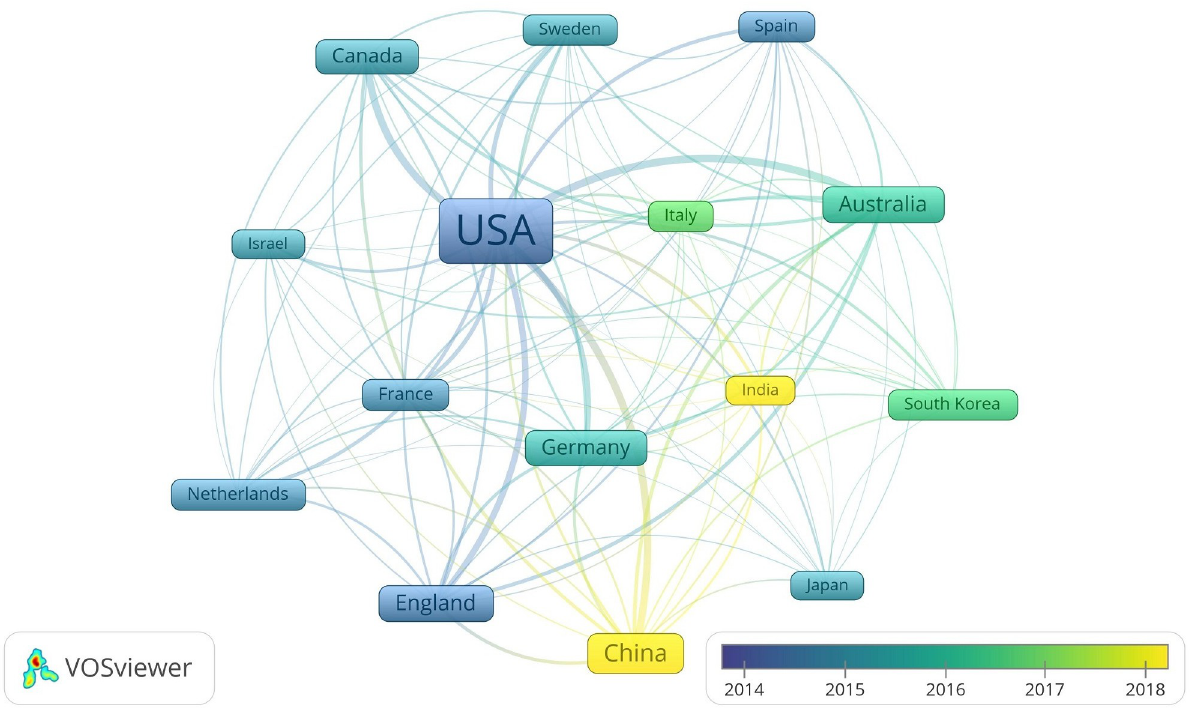
Fig 4. Geographical distribution of